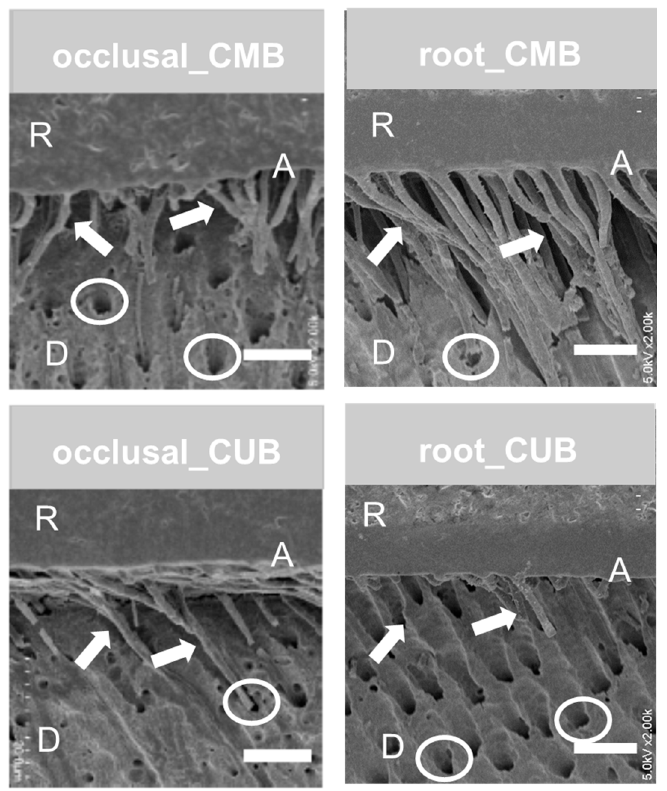
Figure 5. SEM images of adhesive interface. A: adhesive layer, R: composite resin, D: dentin, white arrows: resin tag, white circle: dental tubules. Scale bar: 30 μ m.